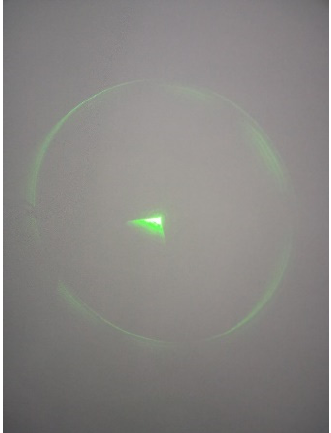
Figure 7. Far-field diffraction spot of the wavefront coded imaging system.